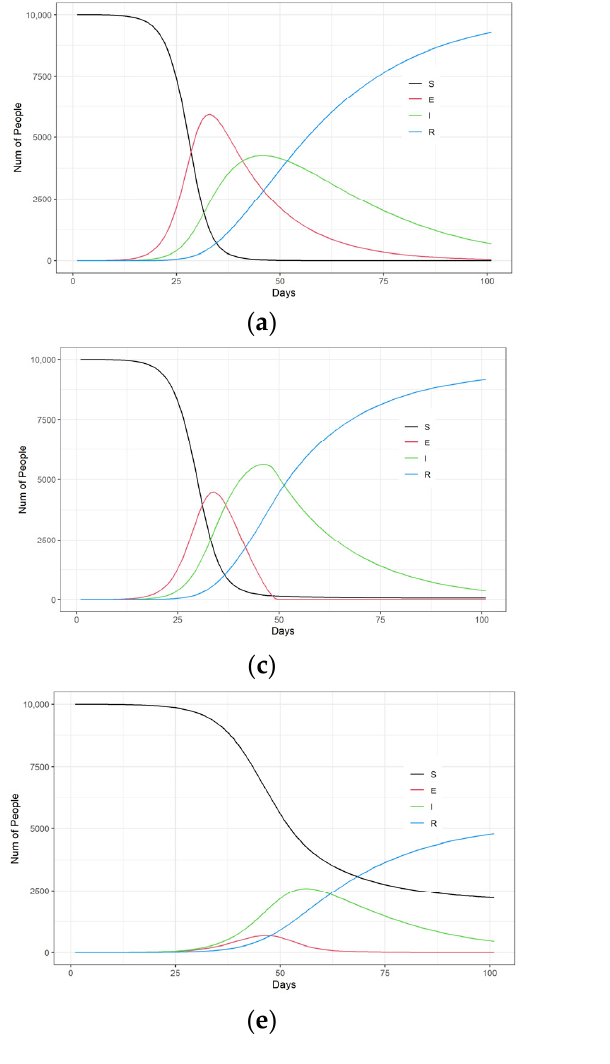
Figure 1. The influence of the daily testing capacity of the epidemic on the evolutionary process of the epidemic. ( a ) Daily testing capacity of 0; ( b ) Daily testing capacity of 100; ( c ) Daily testing capacity of 300; ( d ) Daily testing capacity of 1000; ( e ) Daily testing capacity of 2000; ( f ) Daily testing capacity of